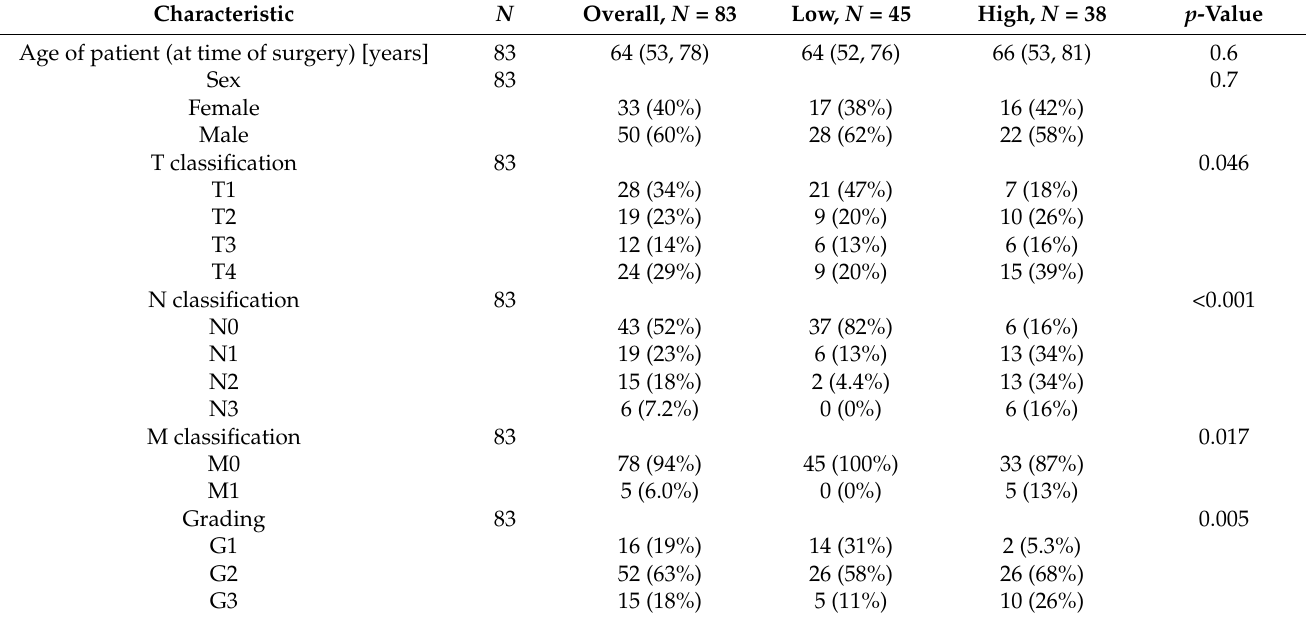
Table 2. Patient characteristics, diagnostic and outcome variables for study